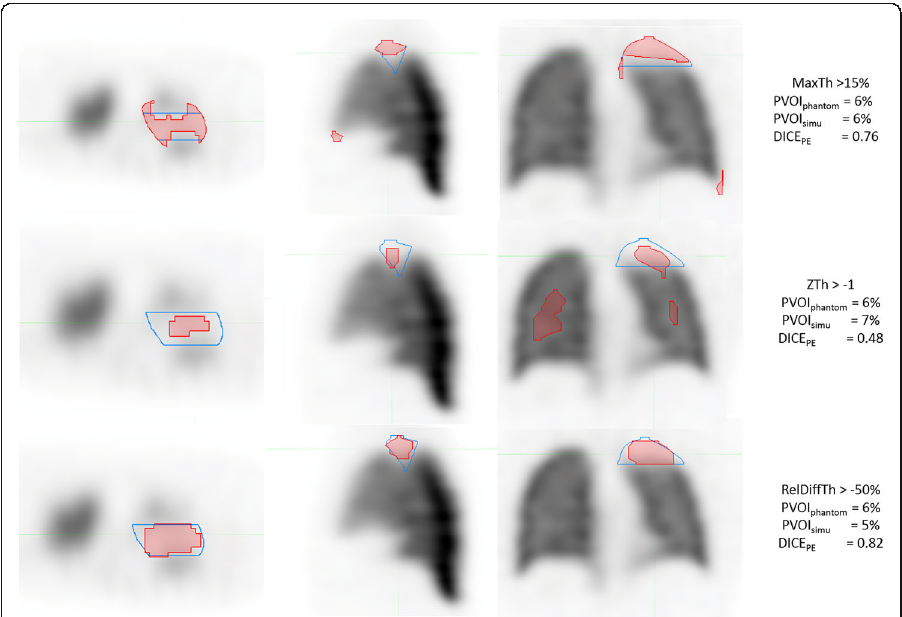
Fig. 8 Example of segmentation for a sub-segmental PE (red) using the MaxTh method (first row), the Zth method (second row), and the RelDiffTh method (third row). Ground truth is delineated in blue. The MaxTh and ZTh wrongly delineated areas without PE. RelDiff method showed high accuracy for small PE delineation